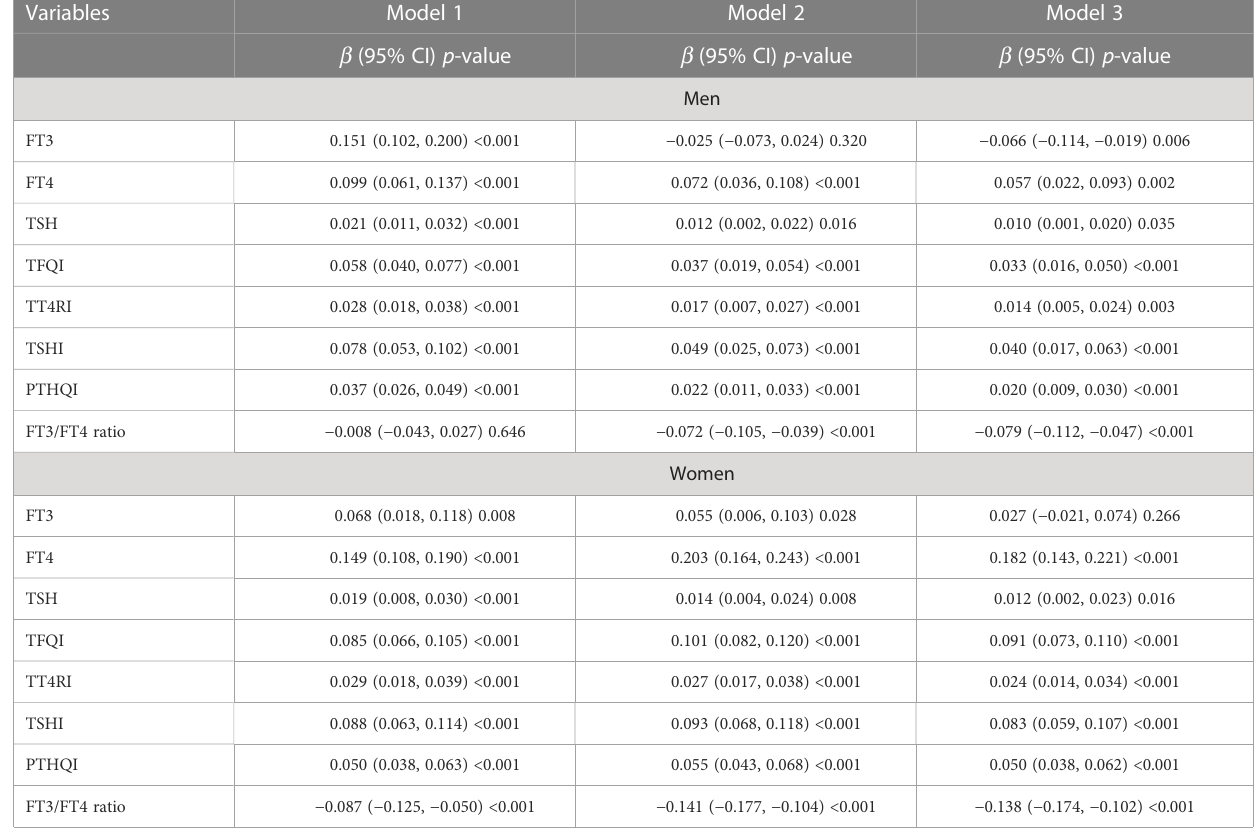
Dataareexpressedasstandardizedcoef fi cients( b )and95%CI.Continuousvariableswithanon-normaldistribution(UA,FT3,FT4,TSH,TFQI,TT4RI,TSHI,PTHQI,andFT3/FT4ratio)were log transformed for analysis. Model 1: Crude model. Model 2: Adjusted for age and BMI. Model 3: Adjusted for age, BMI, diabetes, dyslipidemia, fatty liver, and hypertension.